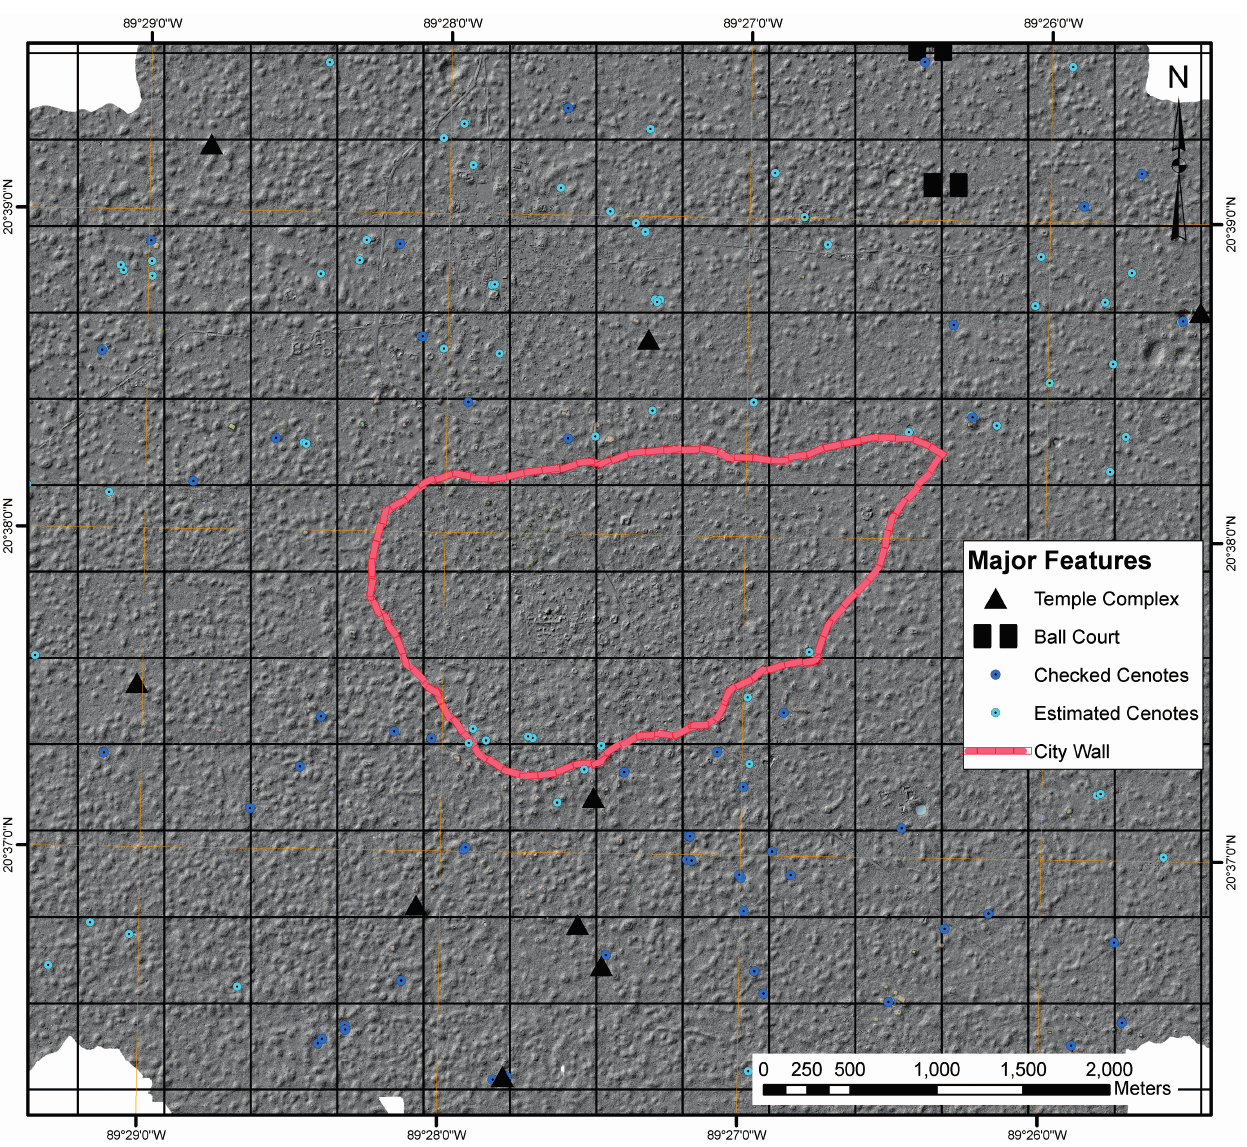
Figure 12. LiDAR-generated digital elevation model (DEM) of the survey area with identified nucleated centers and cenotes in Mayapán’s